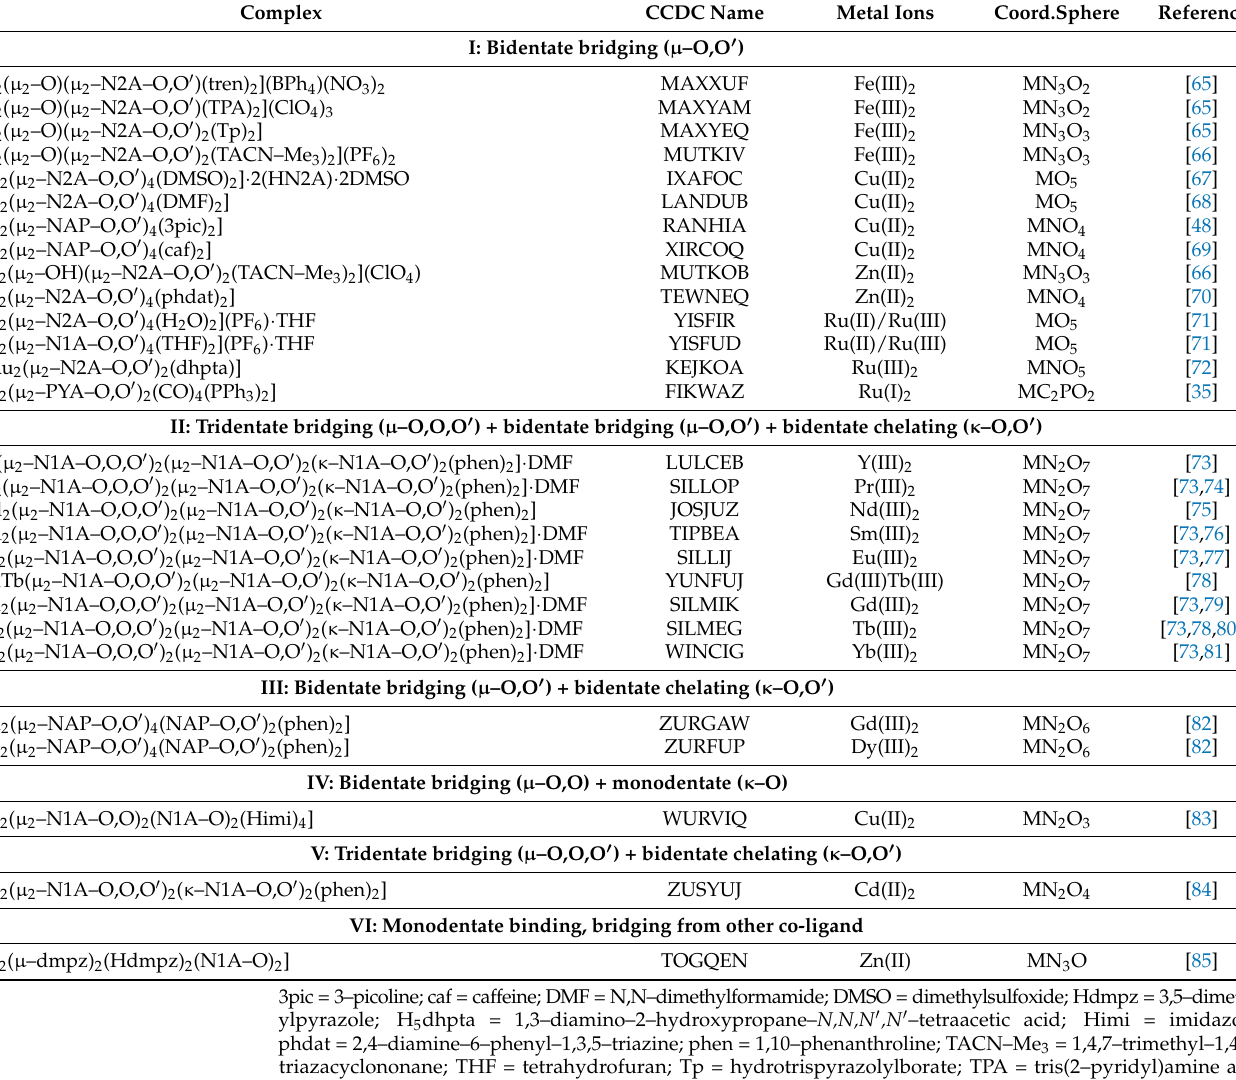
Dinuclear complexes of 1–naphthylacetato, 2–naphthylacetato, naproxen and 1– pyreneacetato ligands. Coordination mode of the ligands, CCDC name of the complex, oxidation state and coordination sphere of the metal ions. Complex CCDC Name Metal Ions